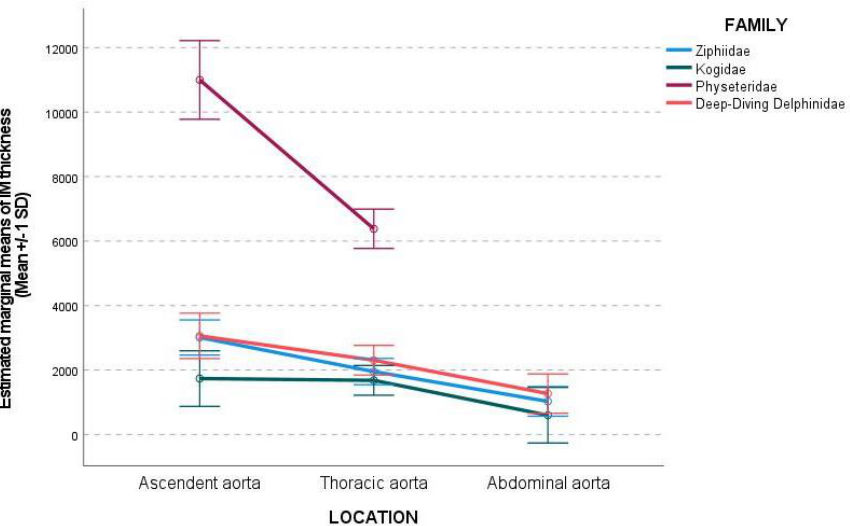
Figure 6. Representation of the aortic wall thickness (μm) at each aortic location by family. A decrease in IM and tunica media thickness was observed between the ascending, thoracic, and abdominal aorta. The difference between ascending and thoracic aorta thickness was higher in the Physeteridae family than in the other families.